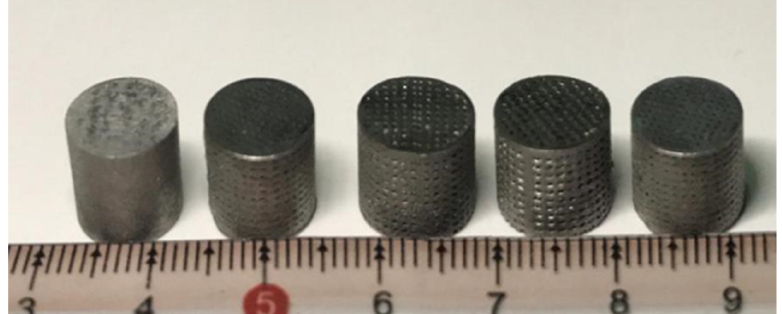
Figure 4. The 316L stainless steel porous scaffolds with different pore diameters, formed byusing SLM.